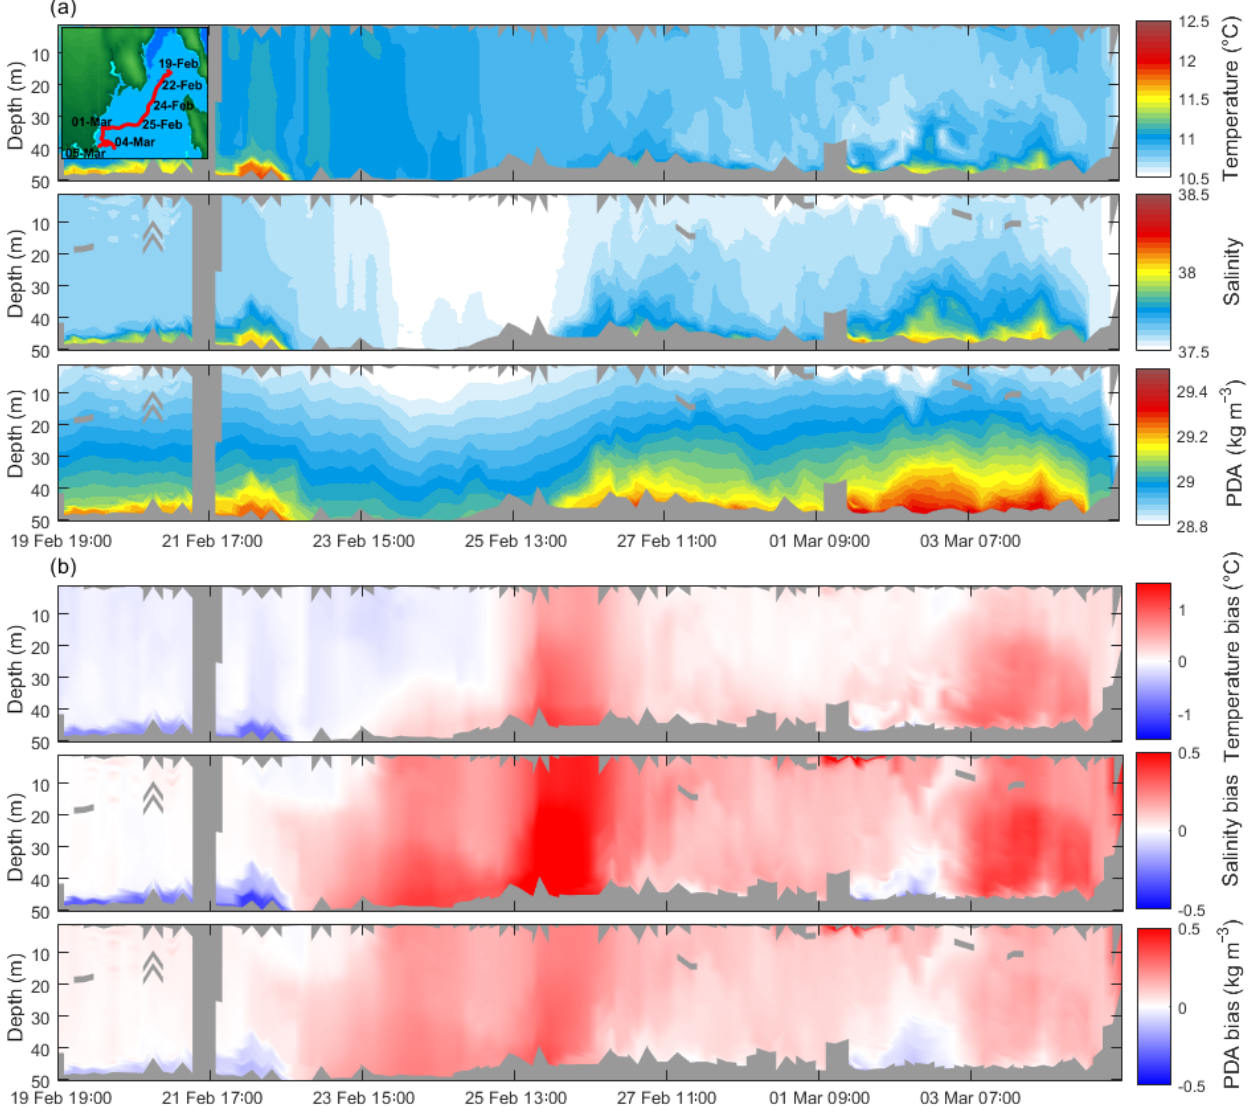
Figure 6. (a) Temperature, salinity and PDA profiles measured between 19 February and 5 March 2015 by the ARVOR-C profiling float in Kvarner Bay, together with (b) model-to-observation difference (bias). Profiling float trajectory is plotted in the inset and Fig. 1. Grey areas denote no